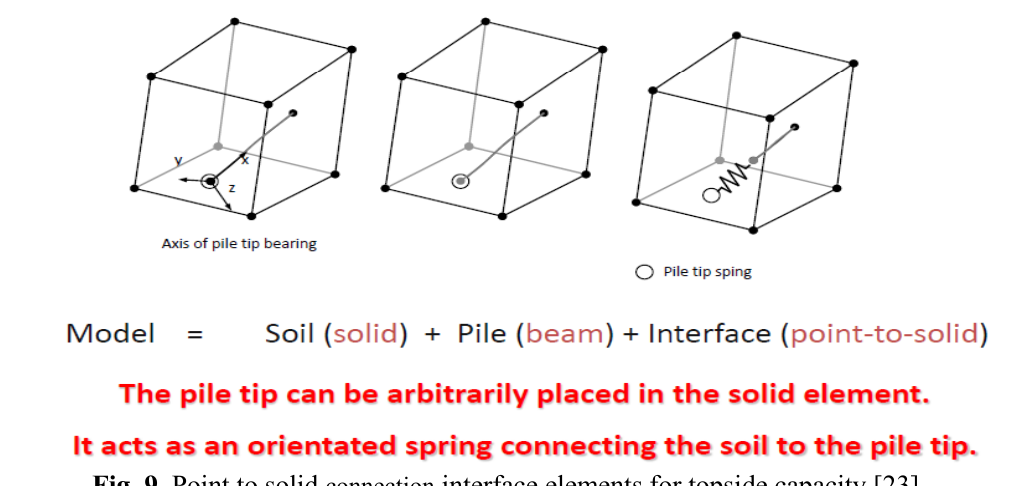
Fig. 9. Point to solid connection interface elements for topside capacity [23].